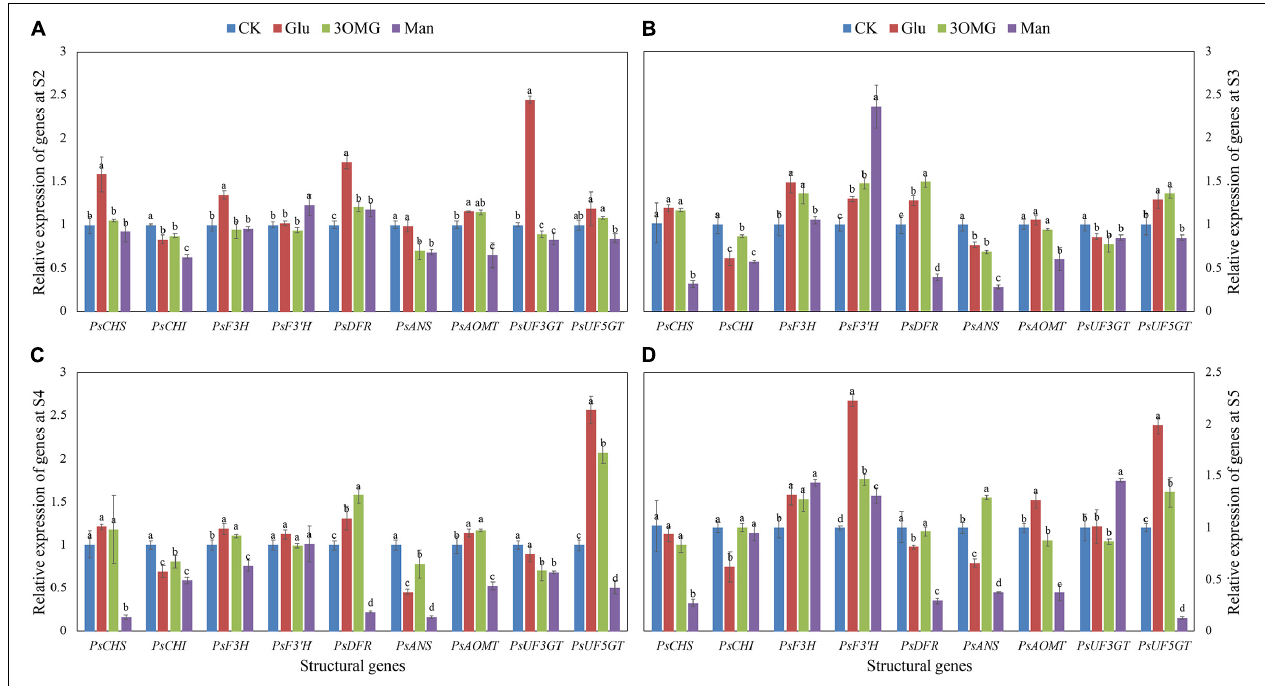
FIGURE 4 | Relative expression levels of nine anthocyanin biosynthetic structural genes in petals of P. suffruticosa ‘Tai Yang’ cut flowers under four treatments. (A) S2, pre-opening stage; (B) S3, initial opening stage; (C) S4, half opening stage; (D) S5, full opening stage. There were four treatments including CK, Glu, 3OMG, and Man, respectively. CK was the control group that cut flowers treated with distilled water. Glu, 3OMG, and Man were the cut flowers treated with glucose, 3-O-methylglucose, and mannose at 333 mM, respectively. Each value was expressed as the mean ± standard errors (SE) of triplicate replications. Different small letters indicated significant differences among treatments at the same developmental stage according to Duncan’s multiple range test at p <